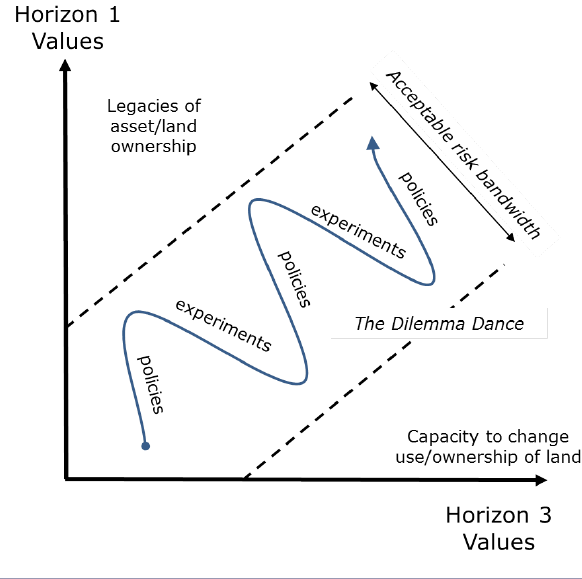
Fig. 4 . The space of dilemmas between the values of Horizon 1 and Horizon 3 in the Carnegie case study. In this space, policies and experiments are used to progress towards